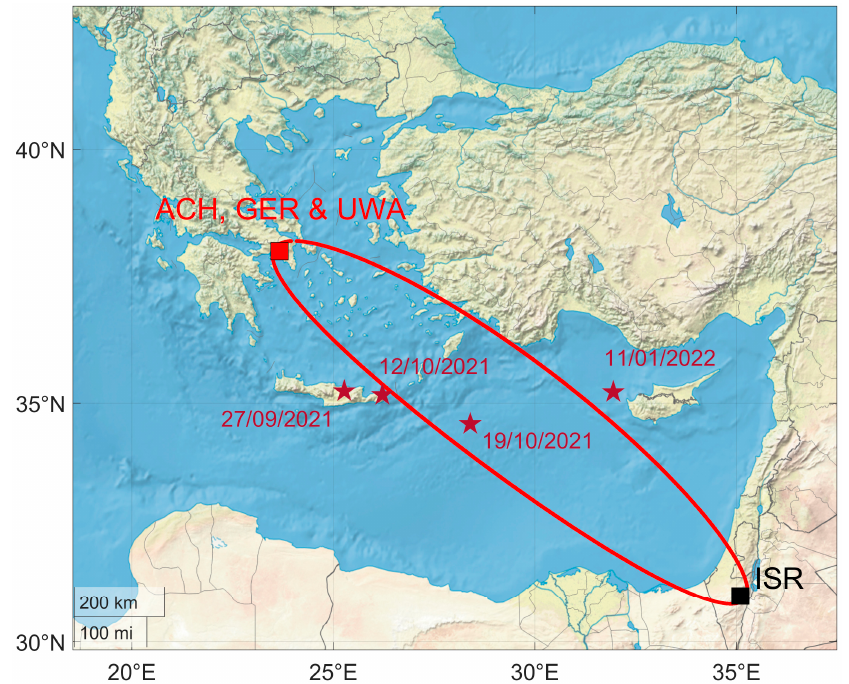
Figure 2. Map of the eastern Mediterranean. The 5th Fresnel zone of the propagation path between the three receivers and the transmitter ISR is indicated, whereas the epicenters of the studied EQs are shown as pentagrams and each occurrence date is shown alongside the corresponding epicenter.